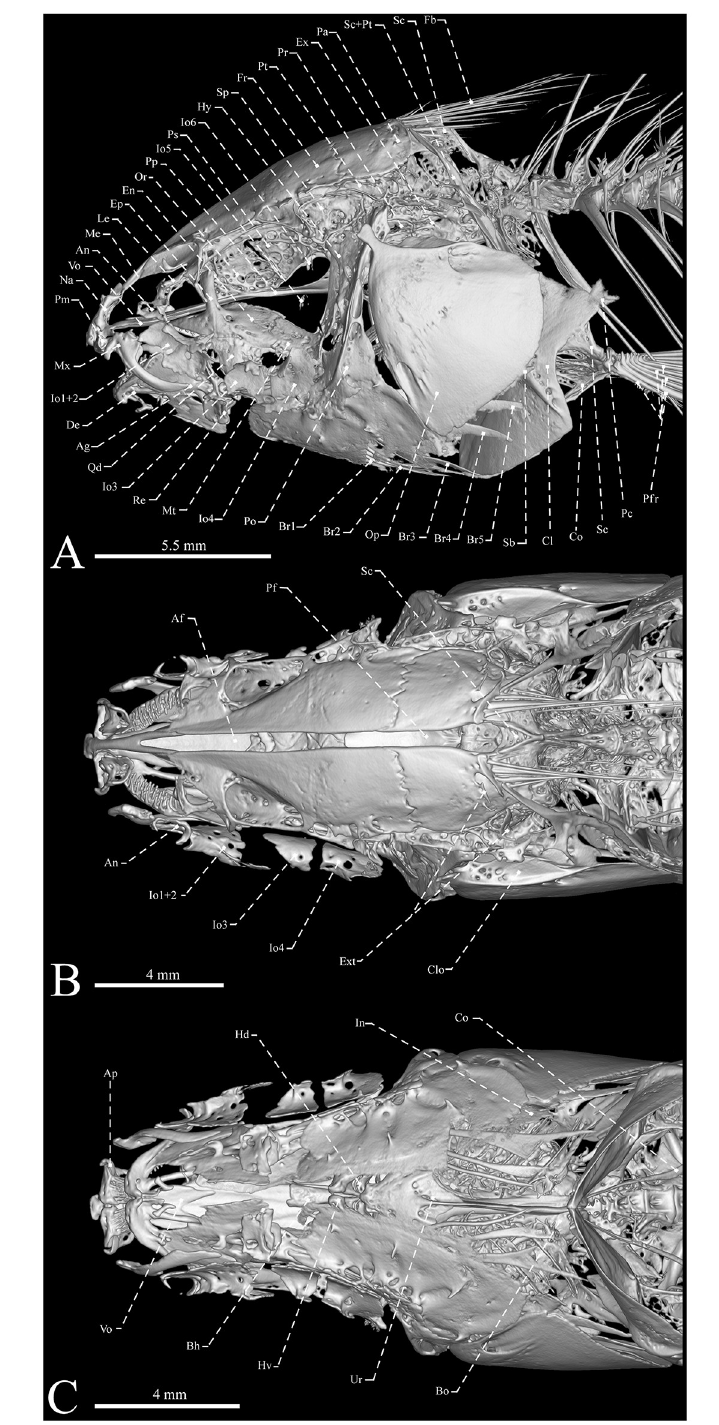
Fig 6. Computed tomography renderings of anterior portion in lateral (A), dorsal (B) and ventral views (C) of Eigenmannia sirius , MZSUP 121668, holotype, 127.5 mm L EA . Af = anterior fontanelle; Ag = anguloarticular; Ao = antorbital; Ap = anterolateral process of premaxilla; Bh = basihyal; Bo = basioccipital; Br = branchiostegal rays; Cl = Cleithrum; Clo = crest of the levator arcus palatini ; Co = coracoid; De = dentary; En = endopterygoid; Ep = endopterygoid process; Ex = exoccipital; Ext = extrascapular; Fb = filamentous bone; Fr = frontal; Hd = hypohyal dorsal; Hv = hypohyahl ventral; Hy = hyomandibula; In = Interopercle; Io = infraorbitals; Le = lateral ethmoid;